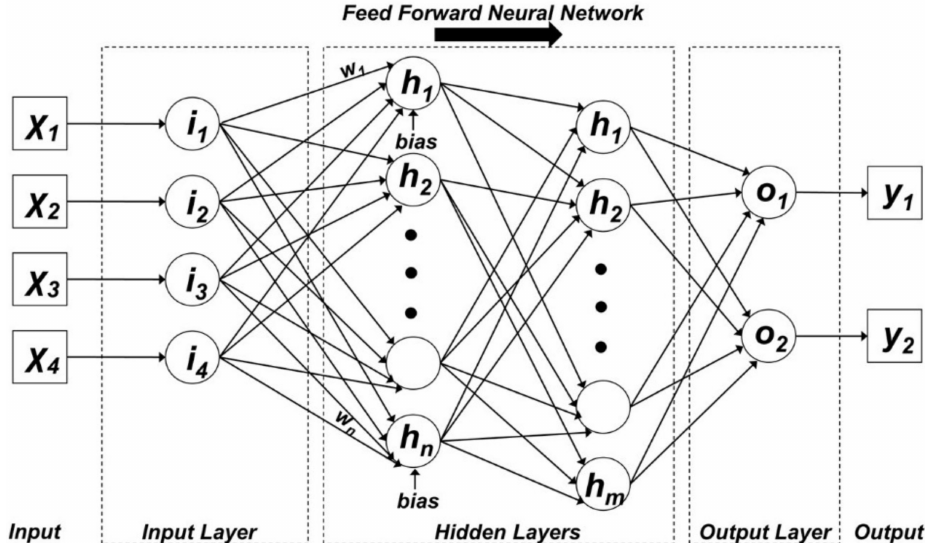
Figure 6. Feed Forward Neural Network consisting of two hidden